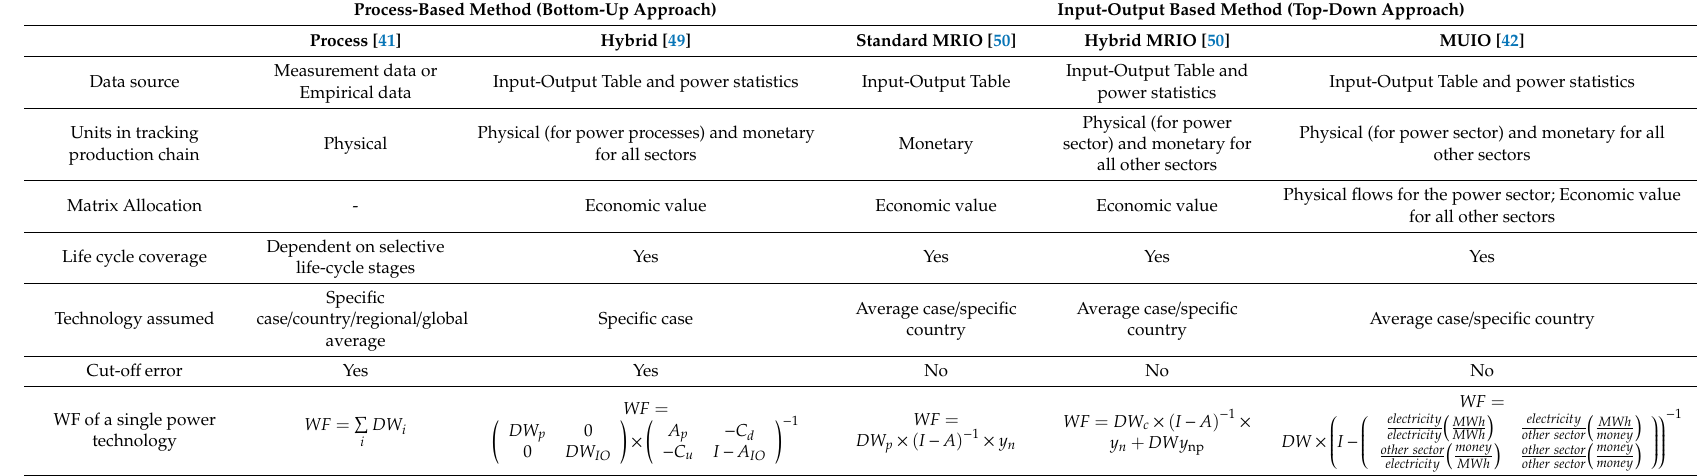
Table 1. Comparisons of di ff erent methods for quantifying water